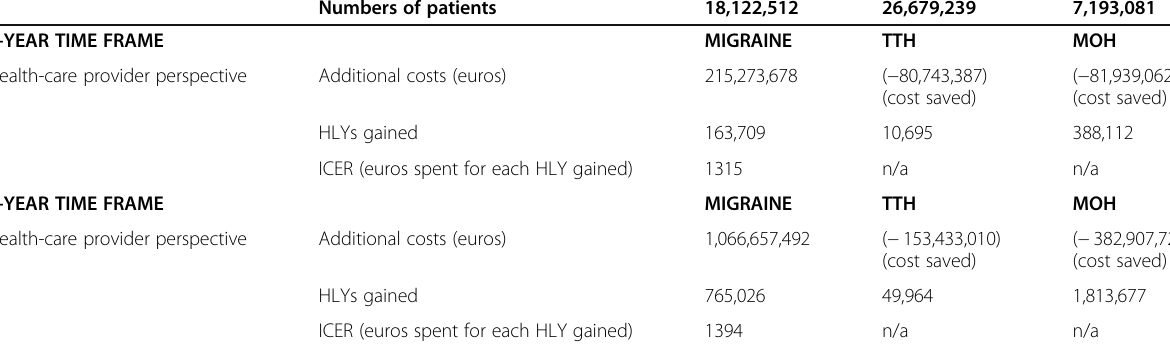
Table 2 Russia: economic consequences of changing from current to target care (population estimates)